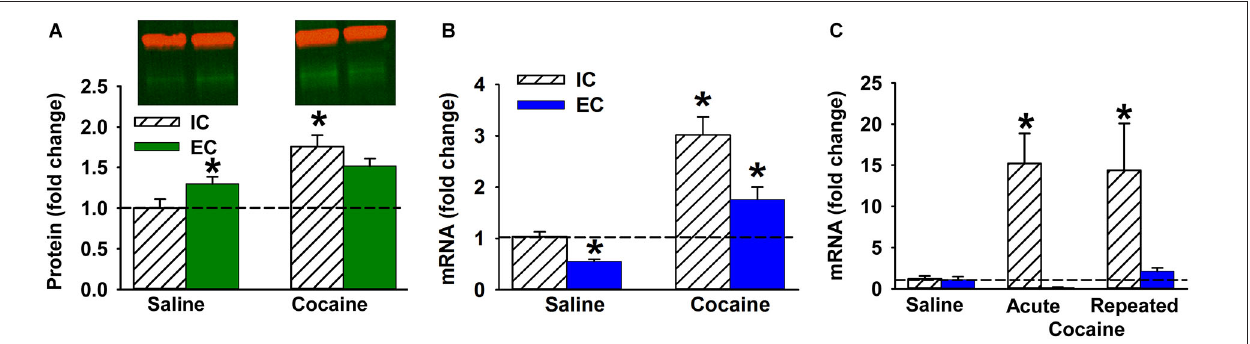
∆ FosB protein. (C) Fold change of ∆ FosB mRNA ( ± SEM) induced by acute or repeated IP cocaine injection in IC and EC rats (30 min; N = 4). Asterisks (*) denote significant difference from corresponding